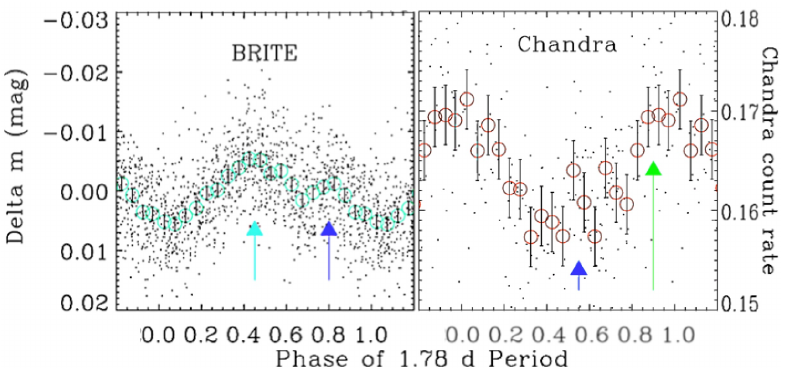
Figure 14. ζ Puppis observed in the visible with BRITE and in X-rays with Chandra, folded with the period of 1.78d. The multi-wavelength light curve behaviour presumably illustrates the effects of Corotating Interaction Regions. The cyan arrows indicate the primary and the blue arrows the secondary maximum. There is a significant shift in the times of maximum due to a large delay or a smaller shift but mismatch in which is primary and secondary maximum (Figure3 of Nichols et al.